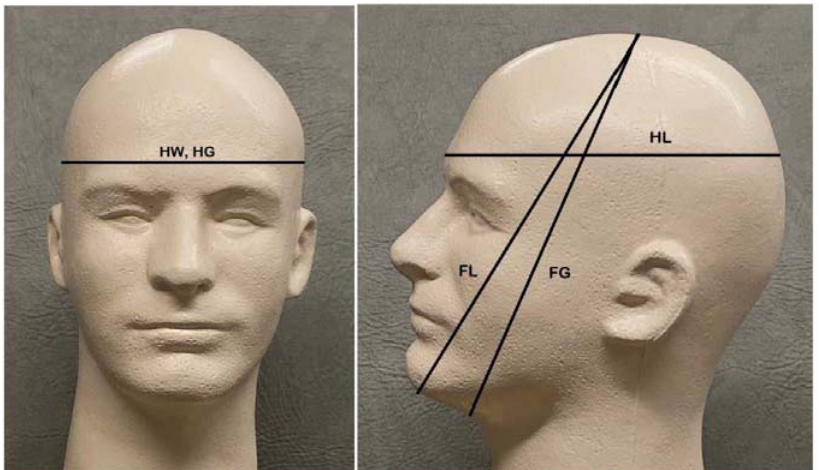
Figure 1. Head measurements. HW, head width: maximum left to right diameter above glabella; HG, head girth: maximum horizontal circumference above glabella; FL, face length: oblique maximum diameter from gnathion to vertex; FG, face girth: oblique maximum circumference under chin to vertex; HL, head length: front to back diameter at the level of the glabella.